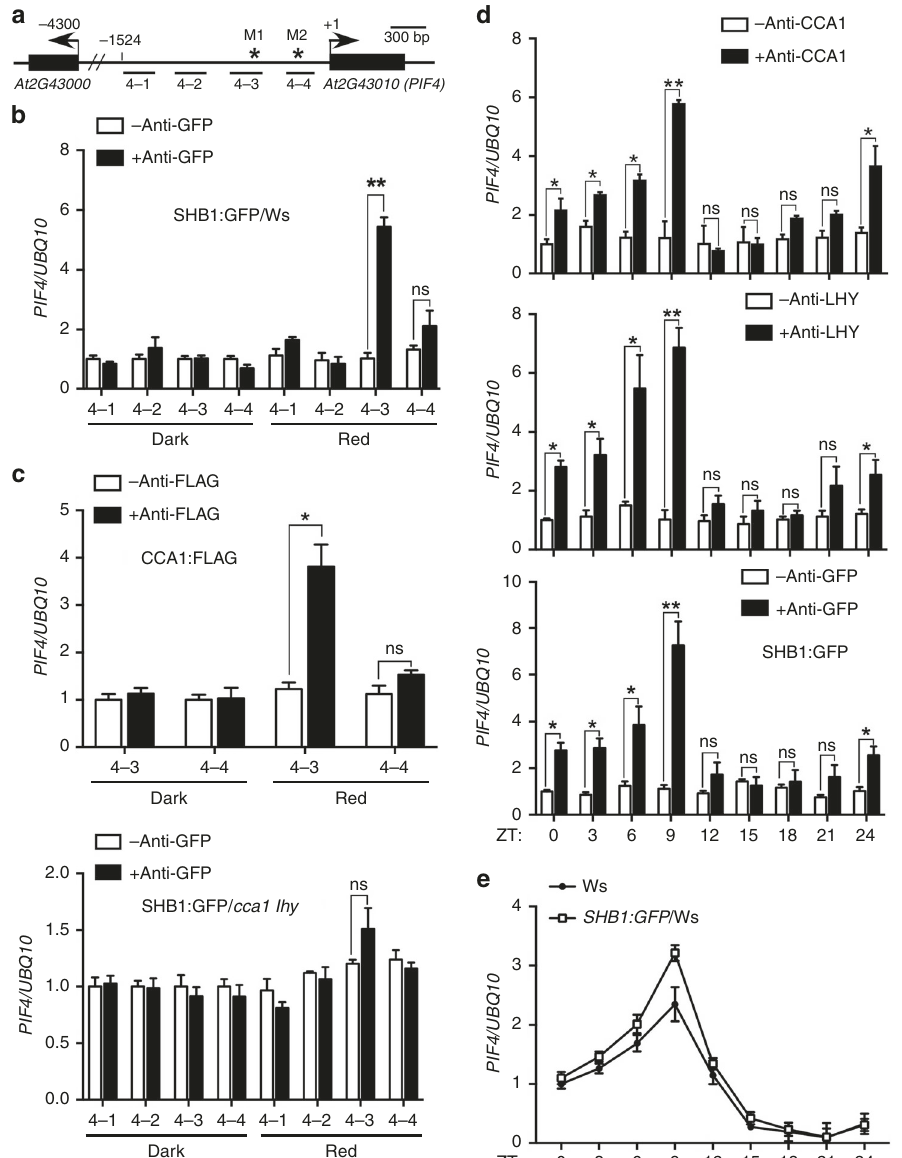
Fig. 4 SHB1 and CCA1/LHY are associated with the PIF4 promoter. a PIF4 promoter demonstrating the chromatin regions (4 – 1, 4 – 2, 4 – 3, and 4 – 4) used for ChIP-quantitative PCR analysis and the potential Myb-binding sites M1 and M2 (asterisks). Association of SHB1:GFP b and CCA1:FLAG or SHB1:GFP in cca1 lhy c with the PIF4 promoter. d Rhythmic association of CCA1, LHY, or SHB1:GFP with the PIF4 promoter under 12-hr dark and 12-hr red light cycles from two biological replicates. Enrichment of DNA fragments was quanti fi ed by qPCR and normalized to that of UBQ10 . e Rhythmic PIF4 expression at various ZT points in Ws and 35 S::SHB1:GFP transgenic plants under 12-hr dark and 12-hr red light cycles. Data are presented as the means ± SE calculated from two biological replicates. Source data are provided as a Source Data fi le